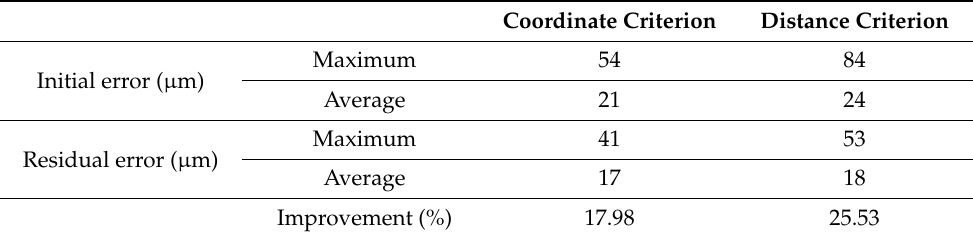
Table 4. Verification values in the calibration procedure.